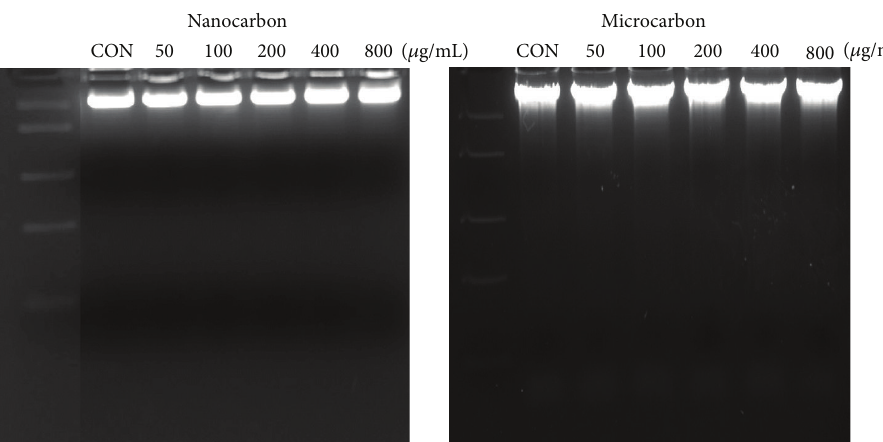
Figure 8: Effect of carbon particles (nano and micro) on DNA of THP-1 cells. The cells were exposed to 50, 100, 200, 400, and 800 𝜇 g/mL of carbon particles for 24 h. Equal amount of DNA (20 𝜇 g) was loaded on agarose gel and visualized under UV